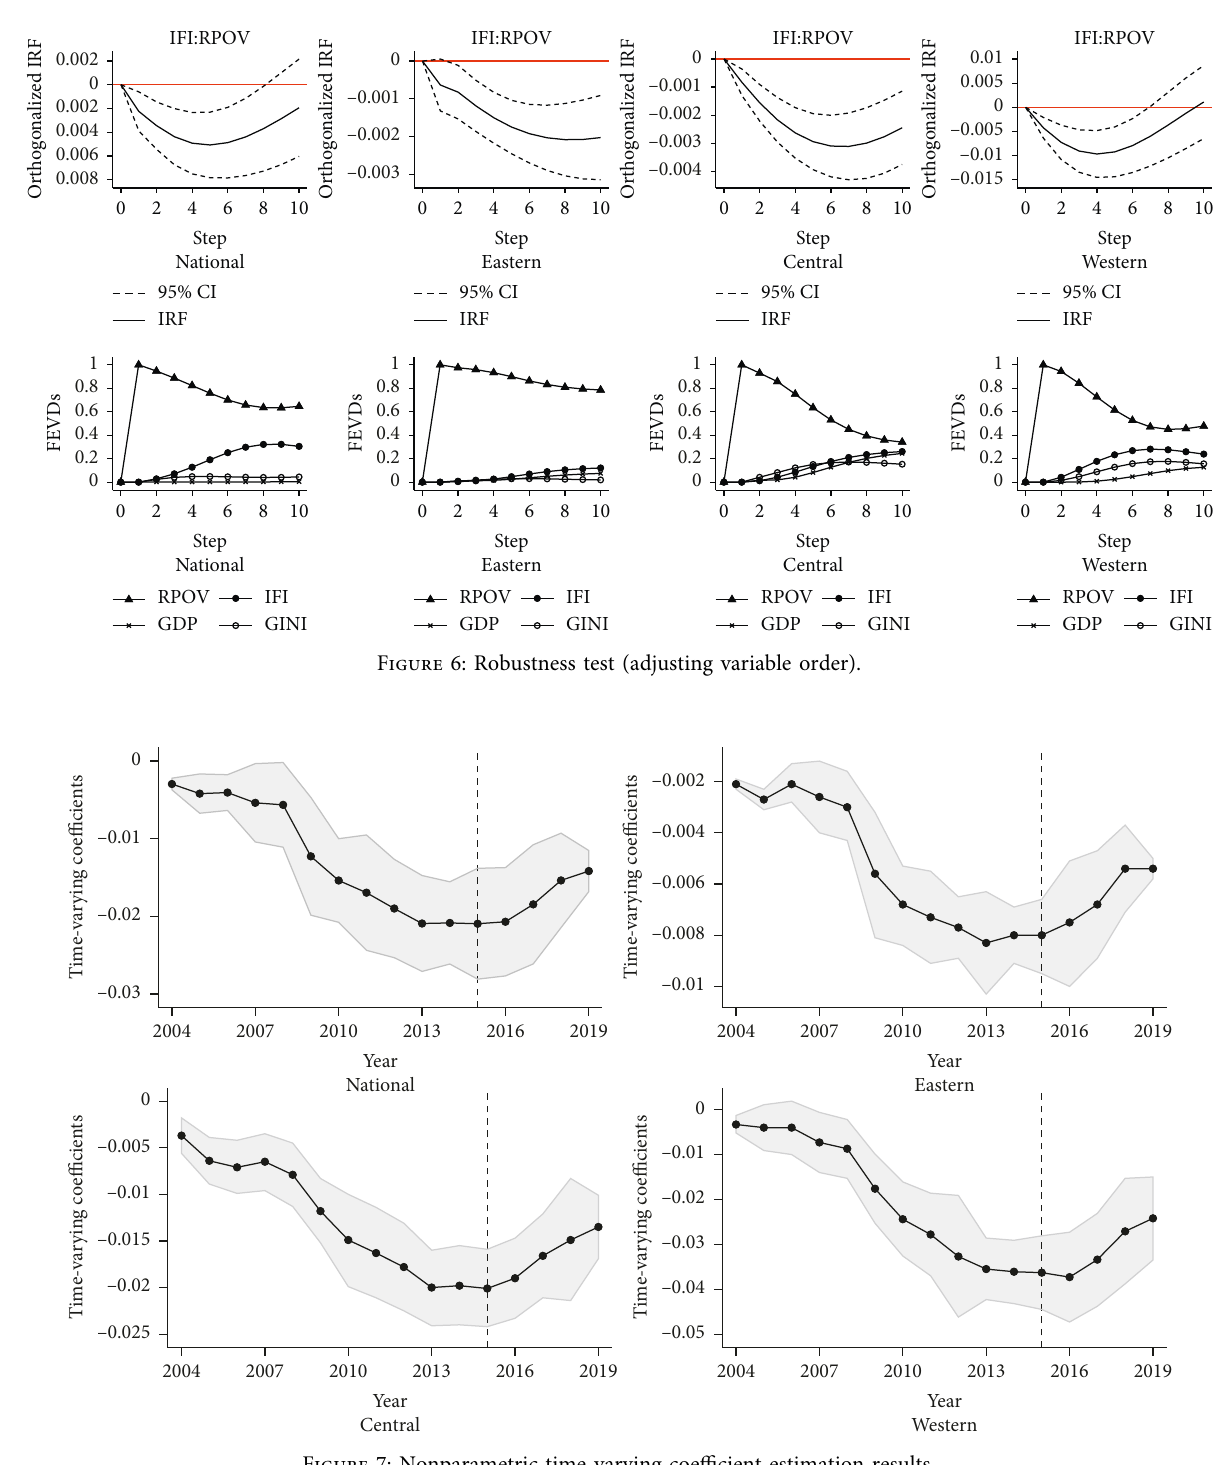
Figure 7: Nonparametric time-varying coefficient estimation